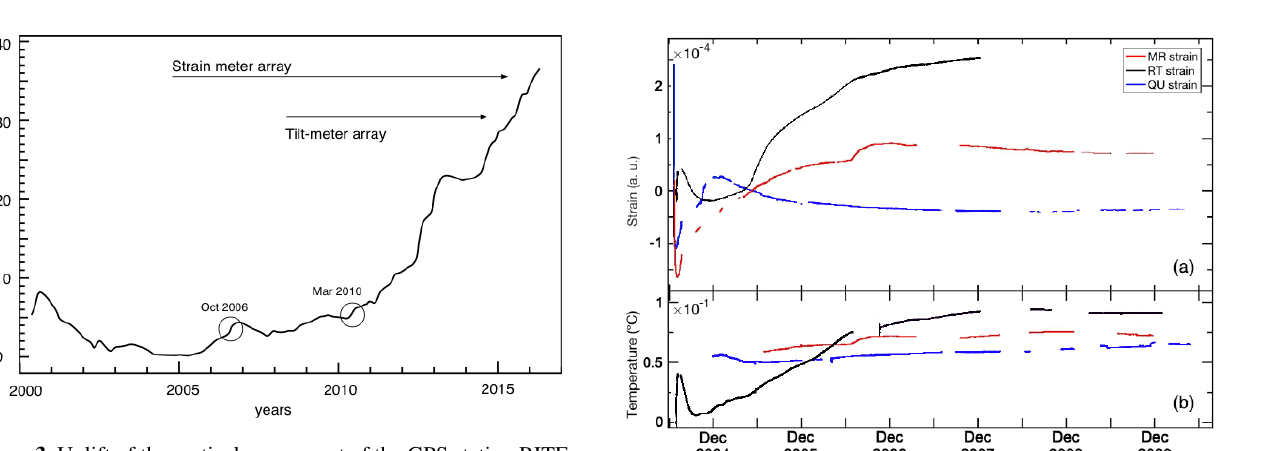
Figure 3. Uplift of the vertical component of the GPS station RITE near Pozzuoli harbour (compiled from Vesuvius Observatory data) showing times of transient accelerations and reversals in inflation rate discussed in text. Time period covered by the datasets of the two arrays used in the present paper is shown in the figure.